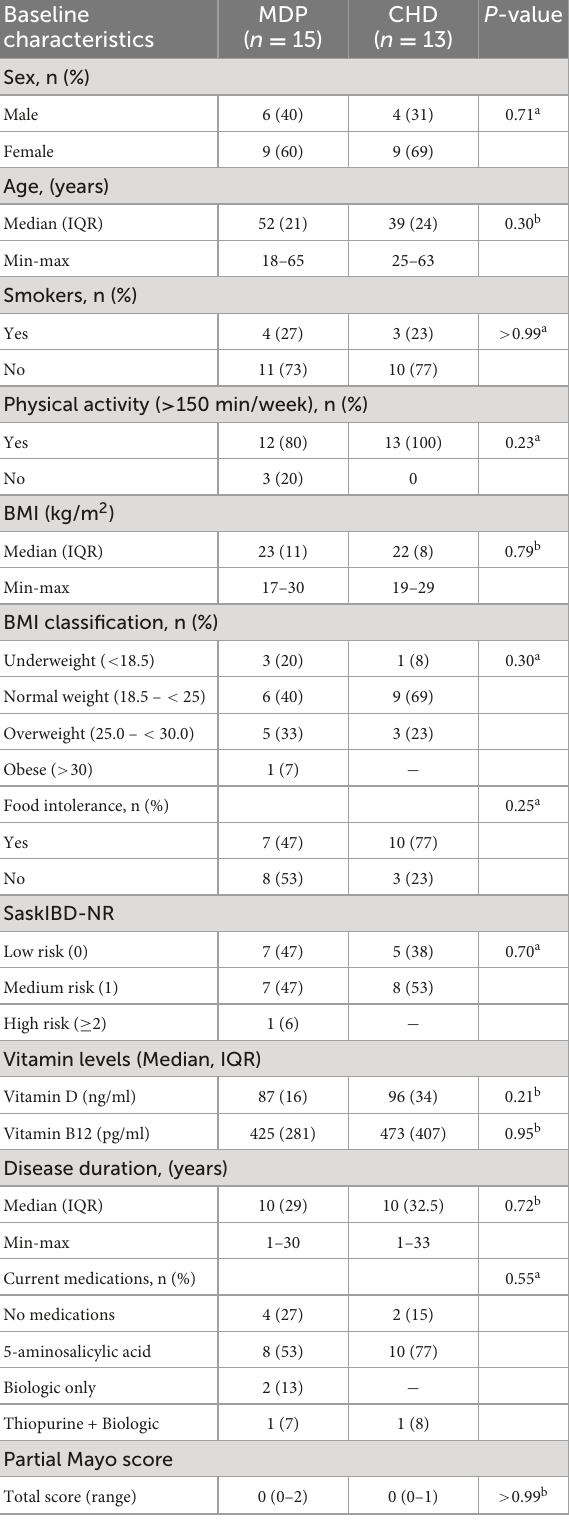
TABLE 1 Baseline characteristics of the study